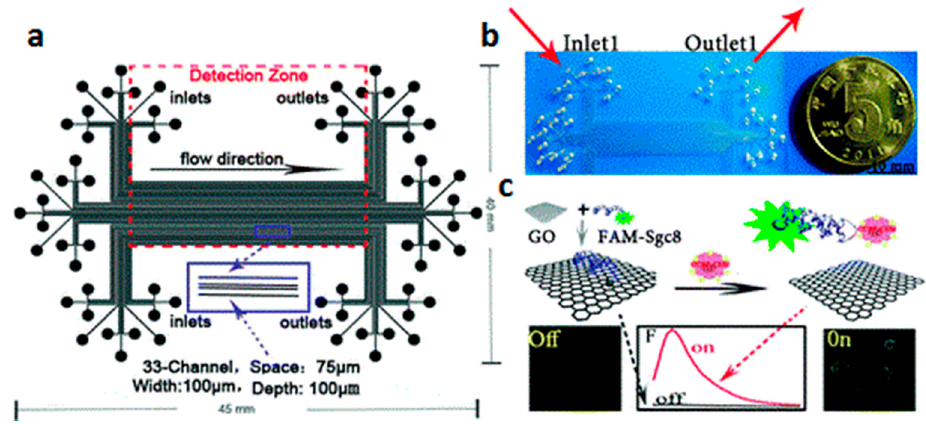
Figure 8. ( a ) Schematic setup and ( b ) the photograph of the GO-based FRET aptasensing microfluidic chip. Scale bar: 10 mm. ( c ) The principle of a ‘signal-on’ aptasensor for detecting CCRF-CEM cells by assaying the cell-induced fluorescence recovery of GO/FAM-Sgc8. Reproduced with permission [130] Copyright 2012, Royal Society of Chemistry.